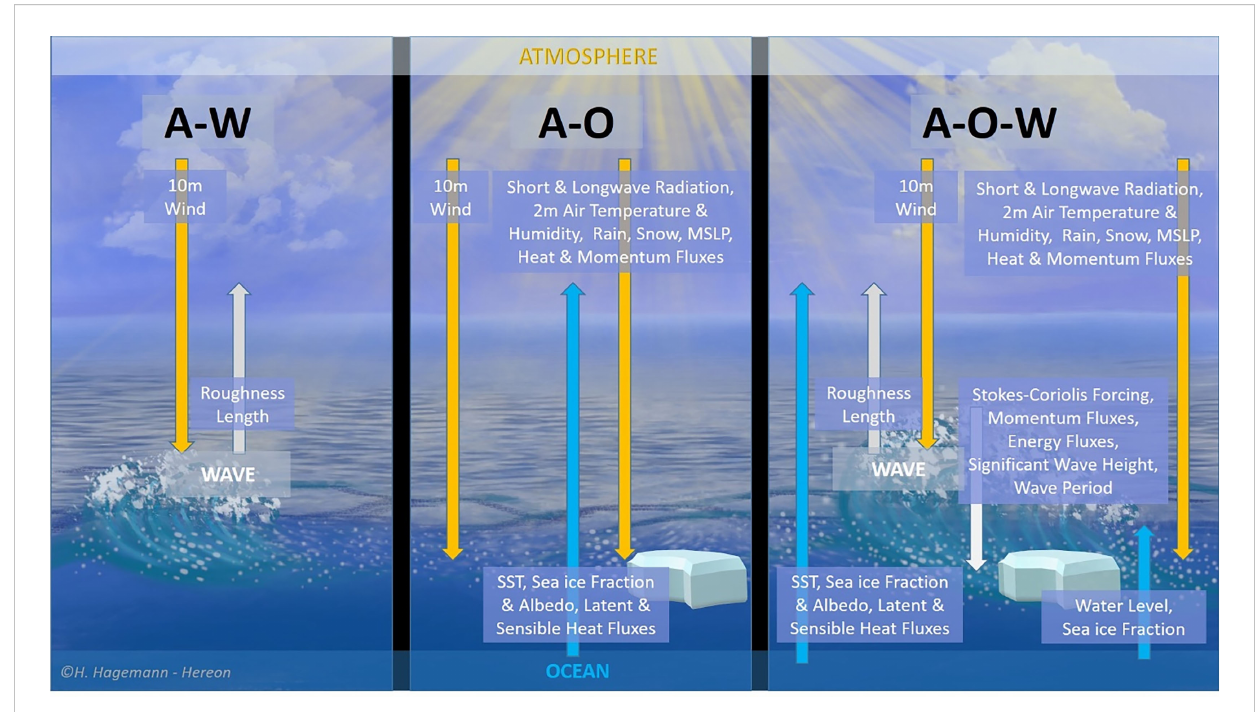
FIGURE 3 Exchanged parameters between atmosphere – wave (AW); atmosphere – ocean (AO); and atmosphere – ocean – wave